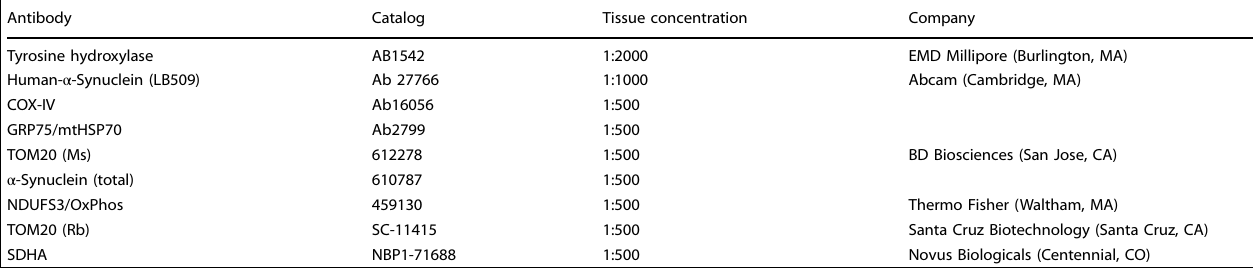
Table 2. Antibody information. Antibody